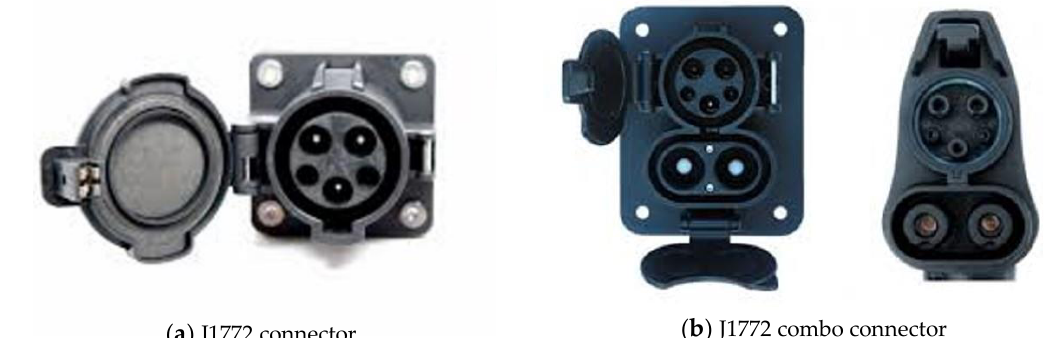
Figure 6. SAE J1772 connector.